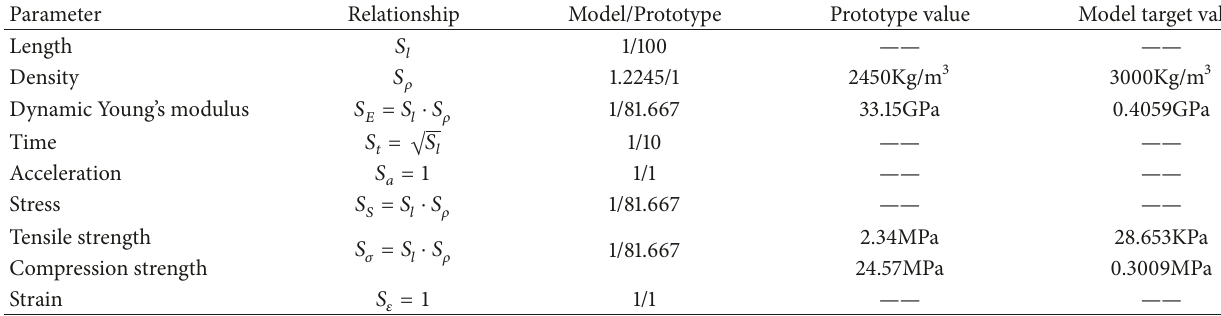
Table 1: Similar ratios for the model test [28].